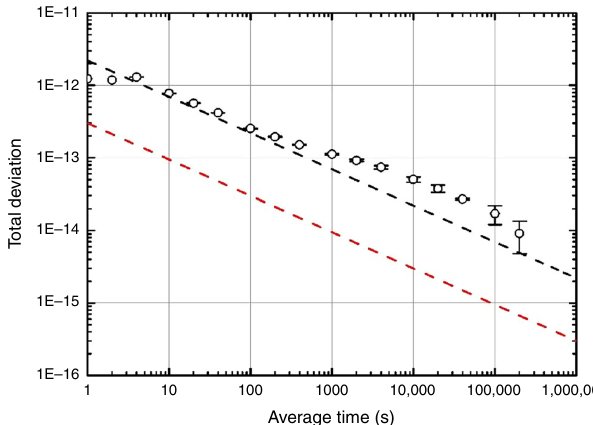
Fig. 8 Frequency stability of the space clock. Black circles represent the measured total deviation against an H Maser on the ground; the black dashed line represents the predicted frequency stability calculated using the measured SNR and FWHM on the ground. The cold atomic cloud is launched downward with a velocity of 1 m s − 1 on the ground. The red dashed line represents the predicted frequency stability in orbit. The error bars represent uncertainty in the total deviation active thermal controller is used to stabilize the cavity temperature to about 25 °C with a stability of ±0.01 °C. Finally, the cold atoms enter the detection zone and pass through four laser beams in succession. The laser beams are set to perpendicular to the trajectory. The fi rst beam is circularly polarized and forms a standing wave tuned to the transition (cid:1) (cid:1) (cid:1) 5 2 S 1 = 2 ; F ¼ 2 . Tuned to the same transition as the fi rst, the second beam is a travelling wave to push away the atoms in state 5 2 S 1 = 2 ; F ¼ 2 after their detection. The third beam is tuned to the transition 5 2 S 1 = 2 ; F ¼ 1 . Finally, the fourth beam is set up like the fi rst but detects the remaining atoms. As designed, the detection system (Supplementary Figure 4) is a compact integrated opto-mechanical system. All the optical components are glued, to improve the thermostability of the detection system, which is athermalized. The induced fl uorescence is recorded by two 10 mm×mm photodiodes with an ef fi ciency of 2% and the photocurrent of each photodiode is converted into voltage using ampli fi ers with a gain of 10 7 AV − 1 . The photodetection has a noise level of less than 3 μ VHz (cid:2) 1 = 2 over the frequencies from 1 to 100Hz which can be ignored in the experiment. The two photodetection signals are digitized by the control electronics to calculate the transition probability. The vacuum tube is built with four individual chambers, each is connected by fl anges to the others. Each fl ange is sealed by Delta seals and indium whereas the optical windows are sealed by indium. To improve the vacuum level of the interrogation zone, two groups of four getters are distributed on the internal sides